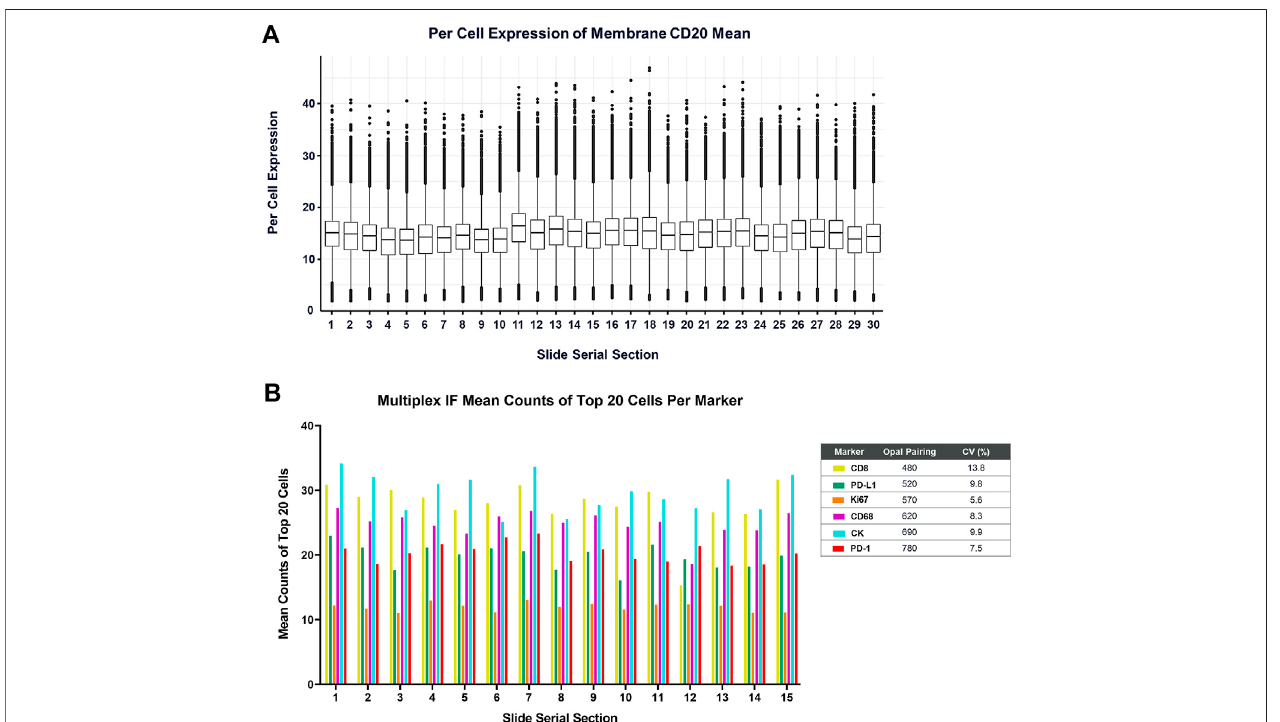
FIGURE 7 | Measurement of the BOND RX performance is captured by (A) running a CD20-Opal 520 monoplex assay across 30 serial sections. The percent coef fi cient of variation (%CV) is calculated by determining the mean expression of the top 20 brightest expressing cells across fi ve matching annotations on all the serial sections. (B) Similarly, an optimized 6-plex, 7-color assay is also run on 15 serial sections, and the mean IF counts of the top 20 cells per marker are measured and the mean, standard deviation, and %CV are